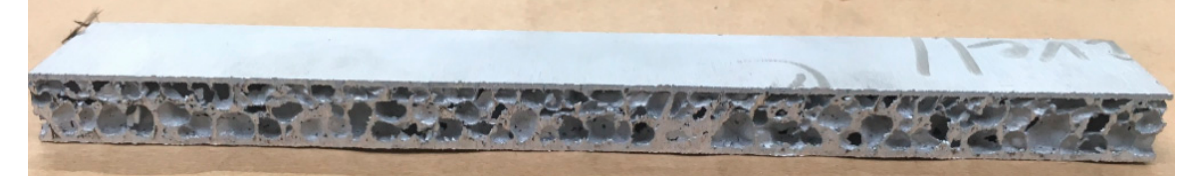
Figure 2. AFSS panel for this work.